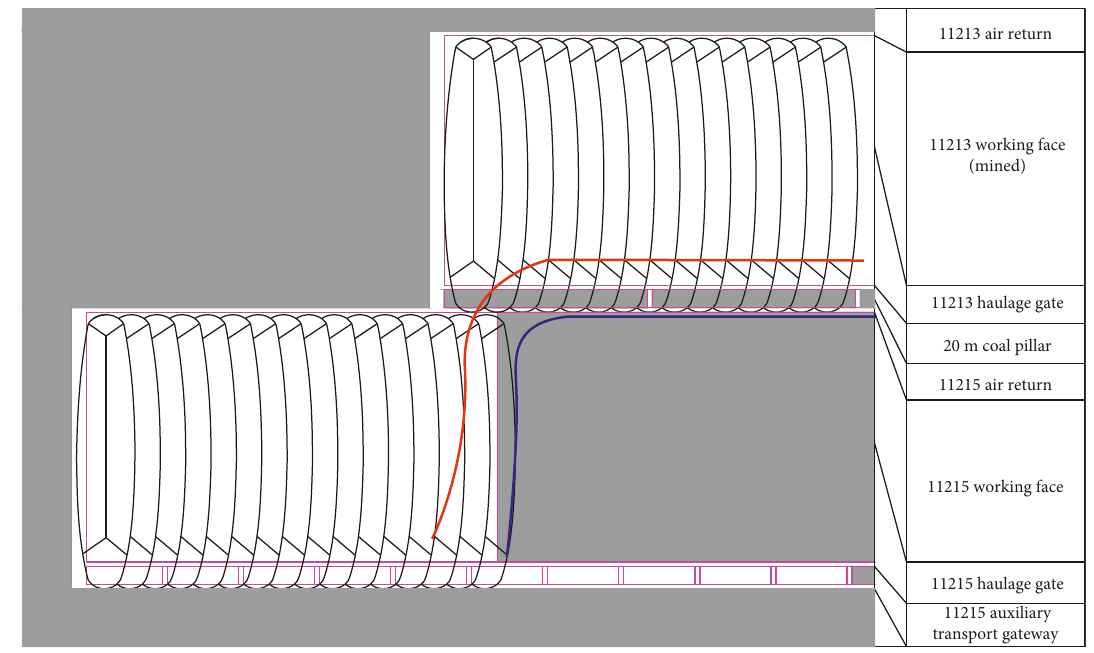
Figure 5: “L-shaped” overlying rock space structure.